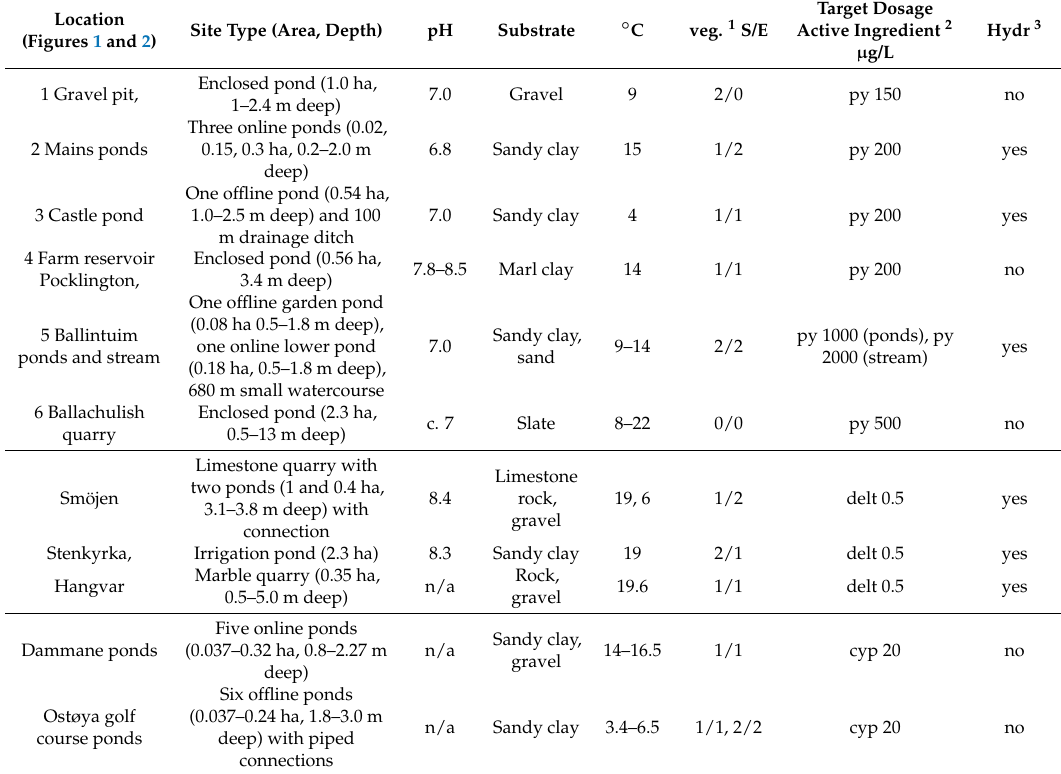
Figure 1. The locations of biocide treatments against signal crayfish in the U.K. (projects 1–6, see Table 1) and other sites where biocide treatment was considered but not carried out (projects 7–13, see Table 2).